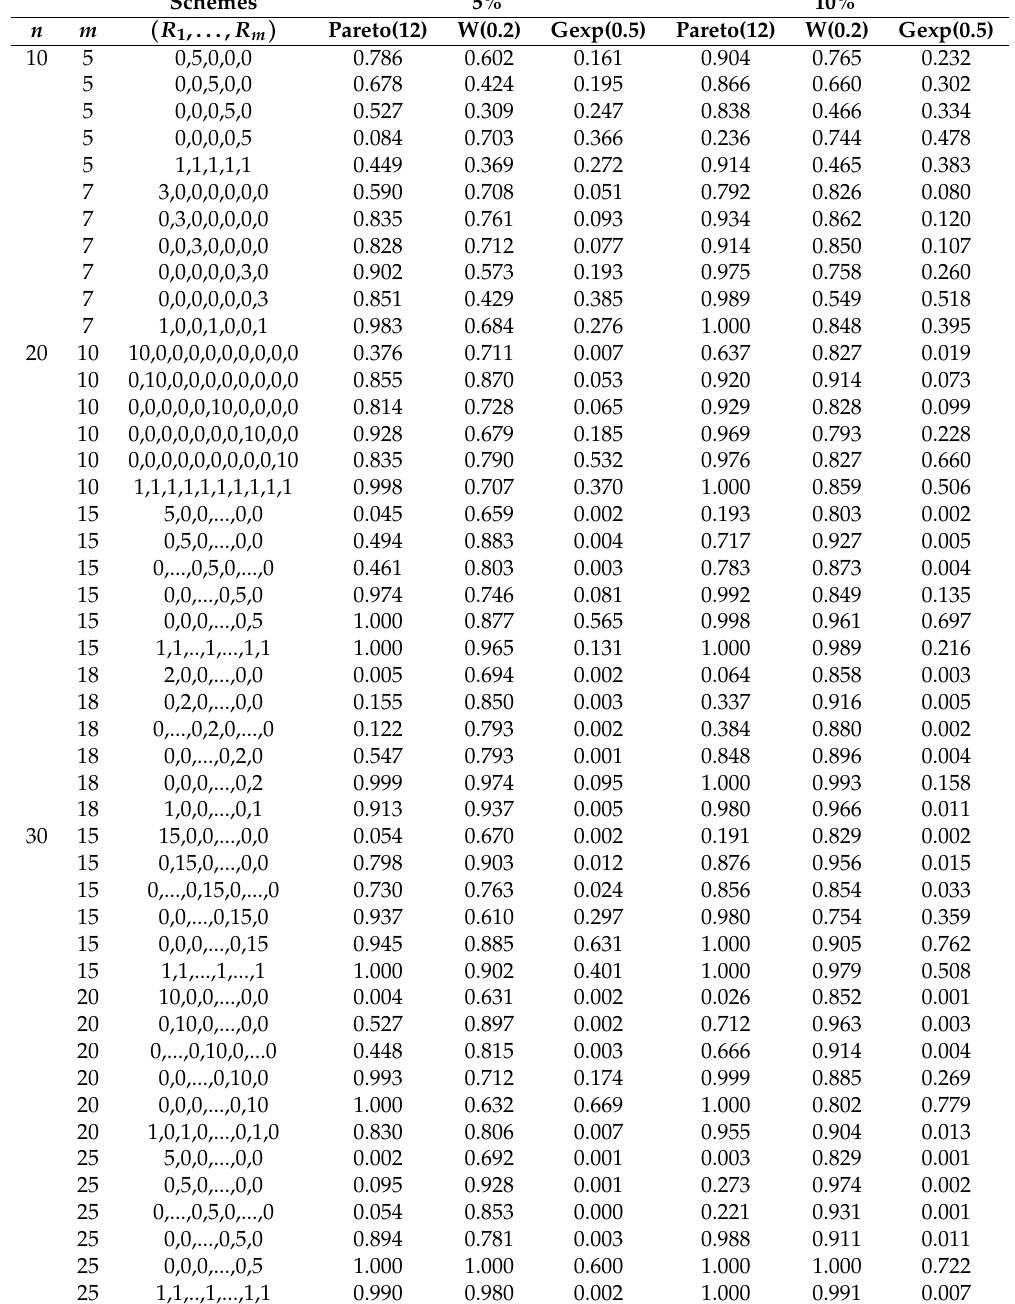
Table 3. Powers of ˆCKL for the monotone decreasing hazard at the 5% and 10% significance levels for the different censorship schemes in the case of sample sizes n = 10, 20, and